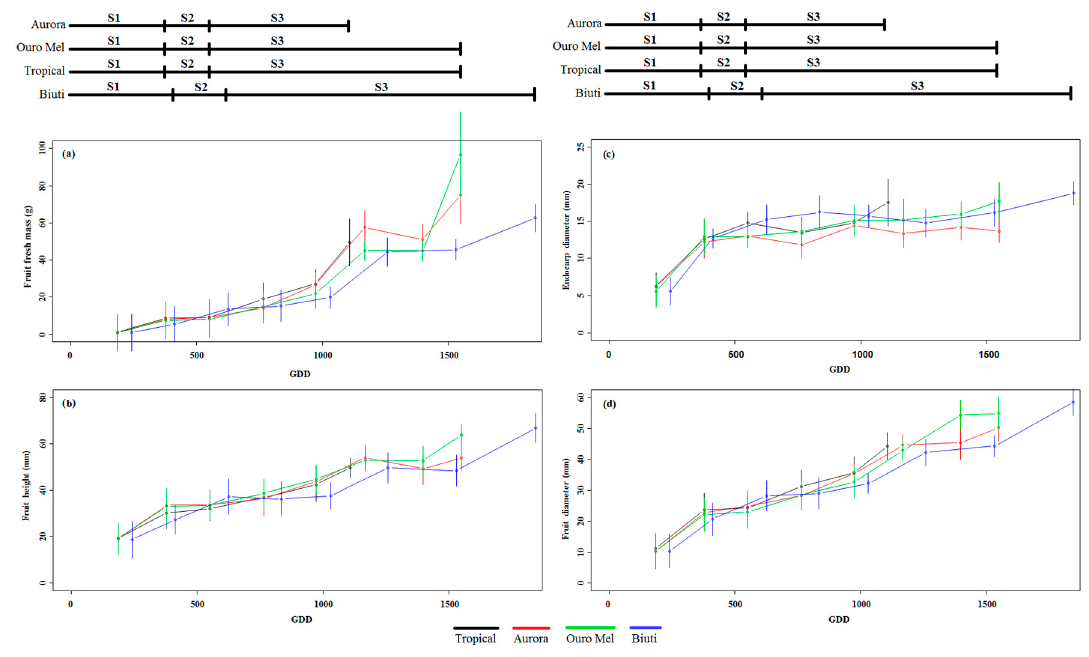
Figure 3. The symbols (S1–S3) above the images represent the peach growth stages. ( a ) Averages of fruit fresh mass (g), ( b ) average fruit diameter (mm), ( c ) average endocarp diameter (mm) and ( d ) average fruit diameter (mm) as a function of growing degree-days (GDD) during peach fruit development (from beginning of flowering to end of harvest) of cultivars grown in a tropical climate region (bars above the averages indicate standard deviations).